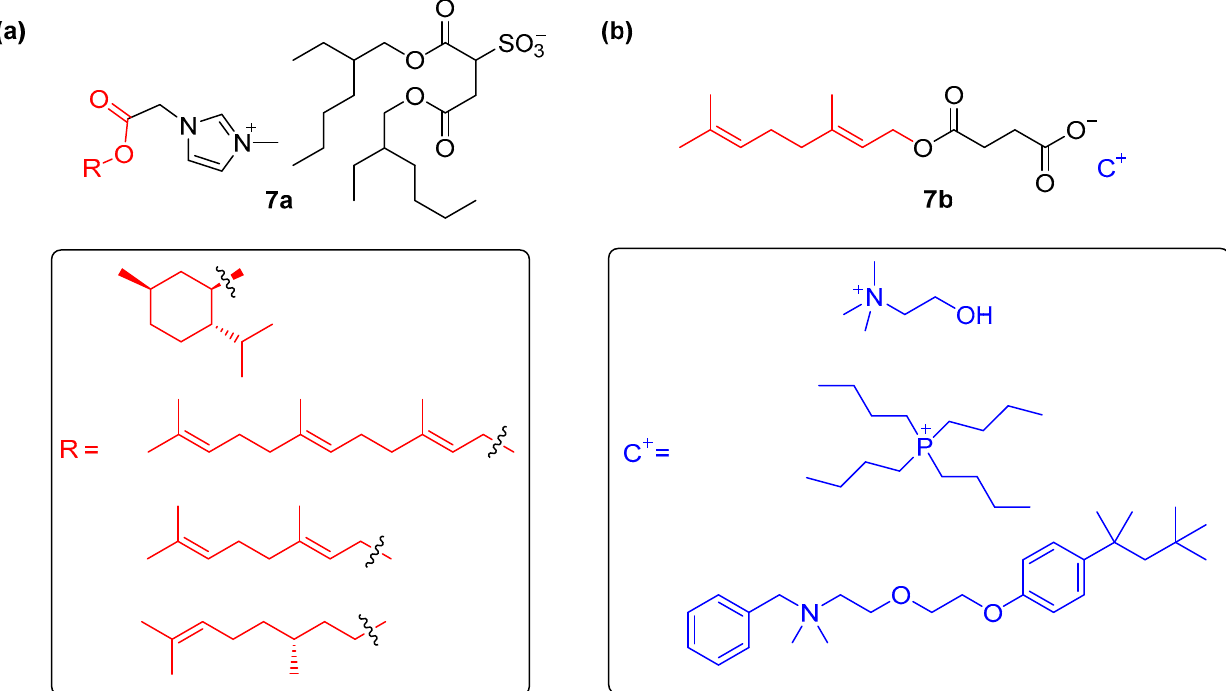
Figure 7. ( a ) Chemical structure of the ionic liquid profragrances 7a , highlighting the precursor of the alcohol scent and showing the fragments of the scents included in a box; ( b ) chemical structure of the ionic liquid profragrances 7b including the different cations in a box. The original results were reported by Rogers and coworkers [58]. The ester hydrolysis reaction which provides the target alcohol-based scents has not been included in the